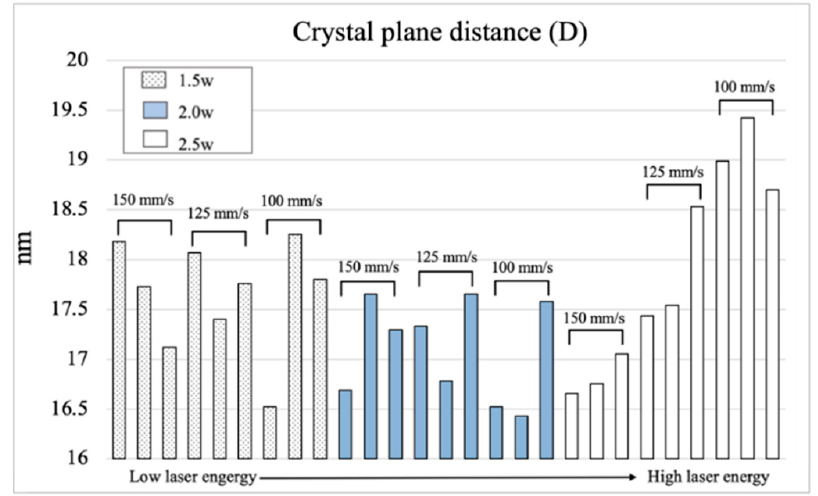
Figure 17. Crystal plane distance of all laser parameters.